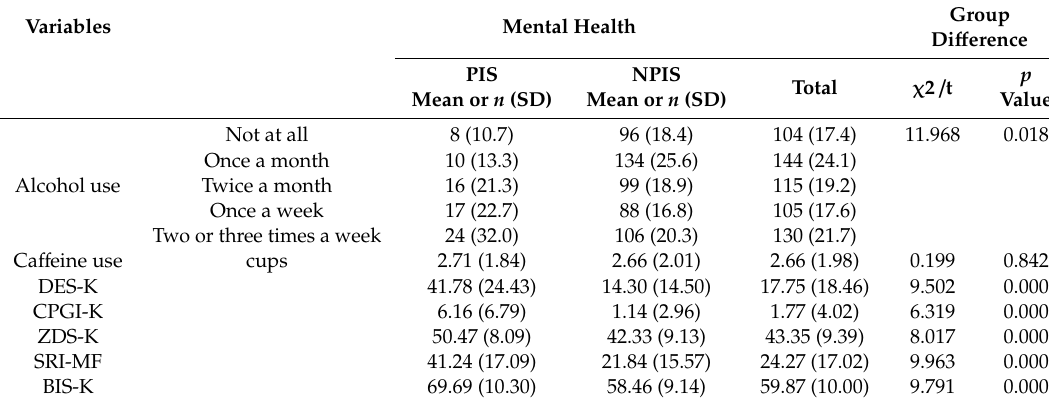
Table 3. Mental health problems in participants with and without